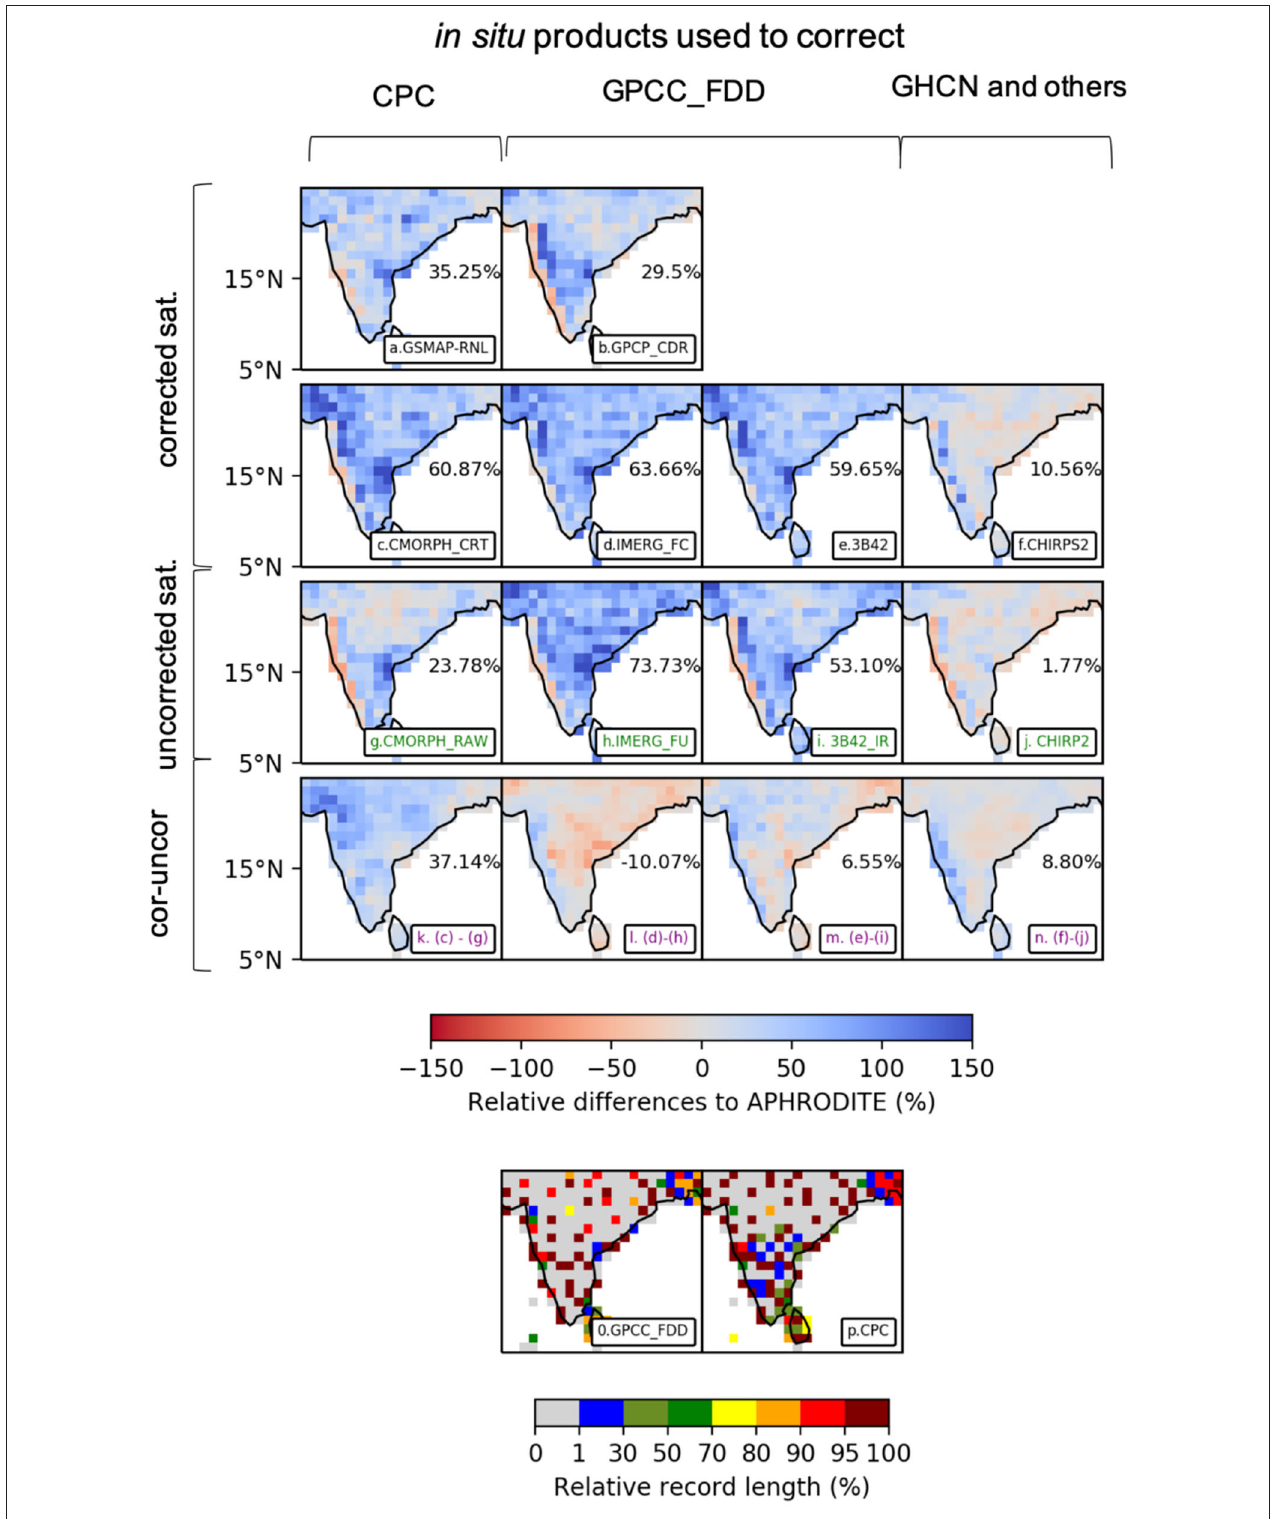
FIGURE 6 | Same as Figure 5 for India. Upper panel: relative difference to APHRODITE (in %) of the climatological (over the period of 2001–2013) annual wettest day (Rx1day) for corrected satellite products (black labels, two upper rows): (a) GSMAP_RNL, (b) GPCP_CDR, (c) CMORPH_CRT, (d) IMERG_FC, (e) 3B42,